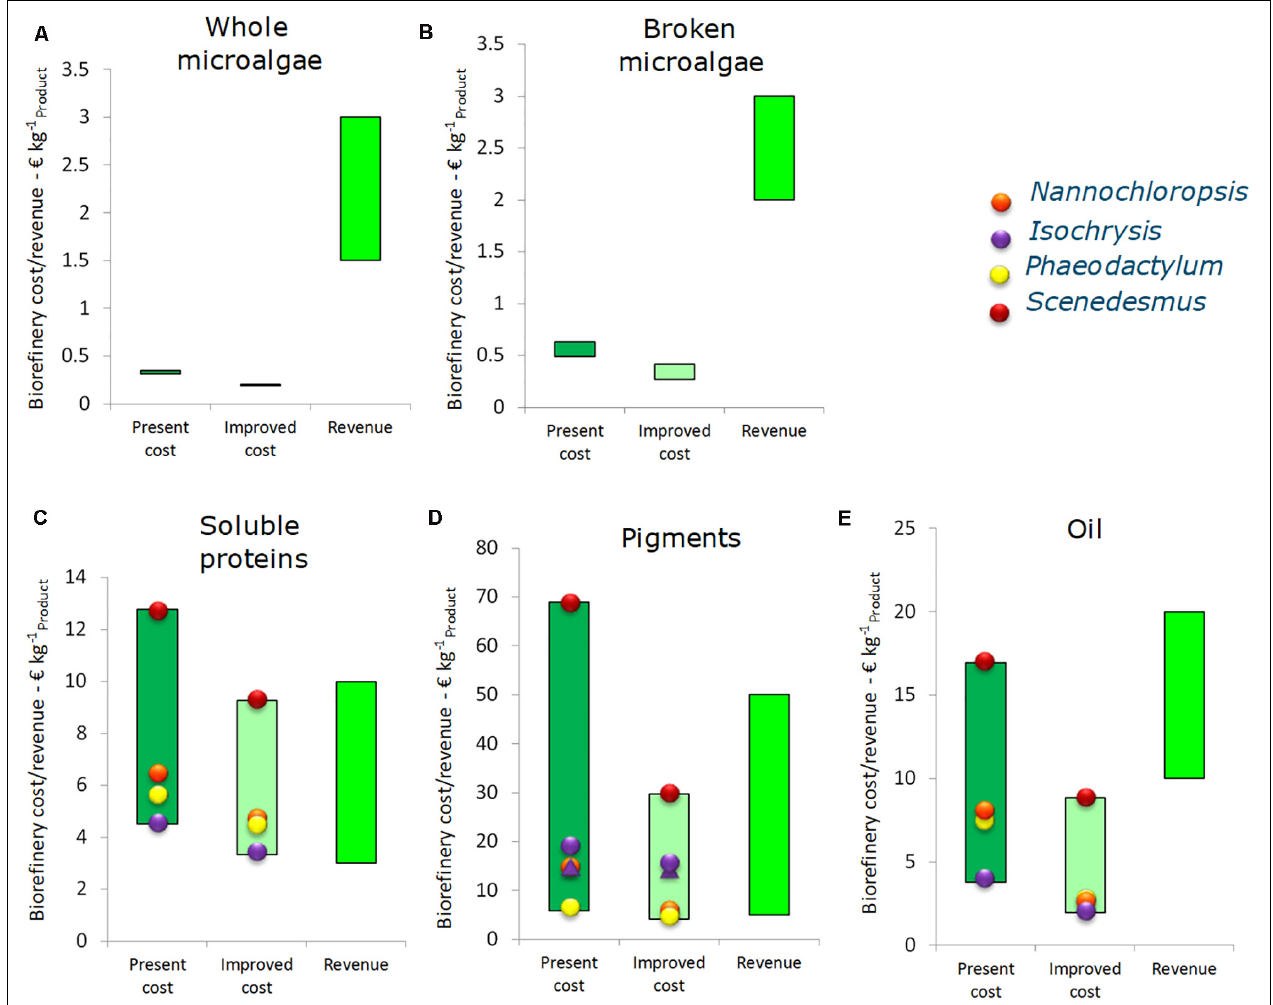
FIGURE 5 | Costs and revenues of the biorefinery process for single product value chain at 10 ktons y - 1 scale (excluding cultivation), expressed per unit of main product. (A) Whole microalgae, (B) Broken microalgae, (C) Soluble proteins, (D) Pigments, and (E) Oil. Costs are reported for benchmark scenario (first bar) and for the scenario leading to reduced cost (second bar, results sensitivity analysis and linear optimization). The revenues (third bar) are further specified in Supplementary Table S5